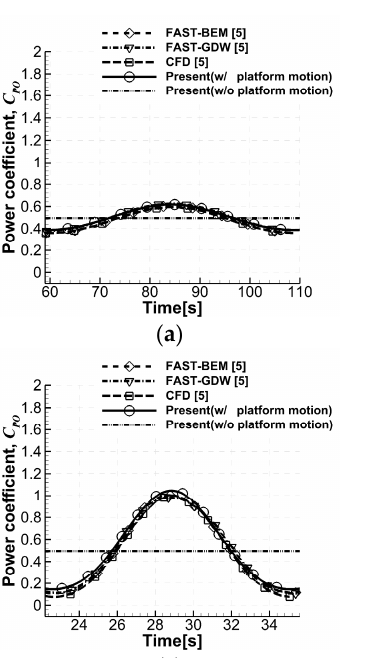
Figure 5. Comparison of rotor thrust coefficient with other numerical predictions. ( a ) Case 1, ( b ) Case 2, ( c ) Case 3, and ( d ) Case 4.